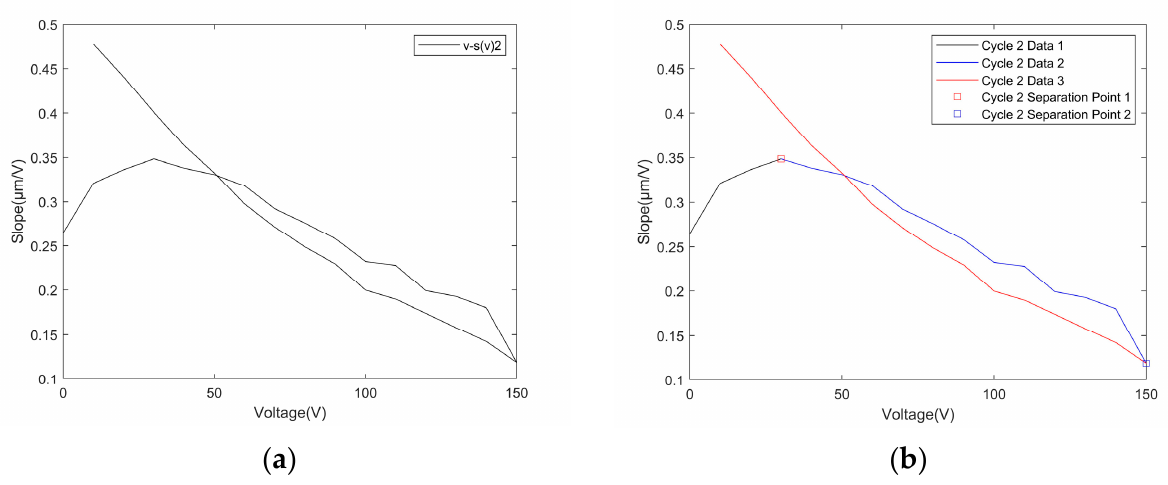
Figure 13. Voltage–hysteresis tangent slope plots: ( a ) new second cycle v-s(v) plot; ( b ) new second cycle slope data separation plot.